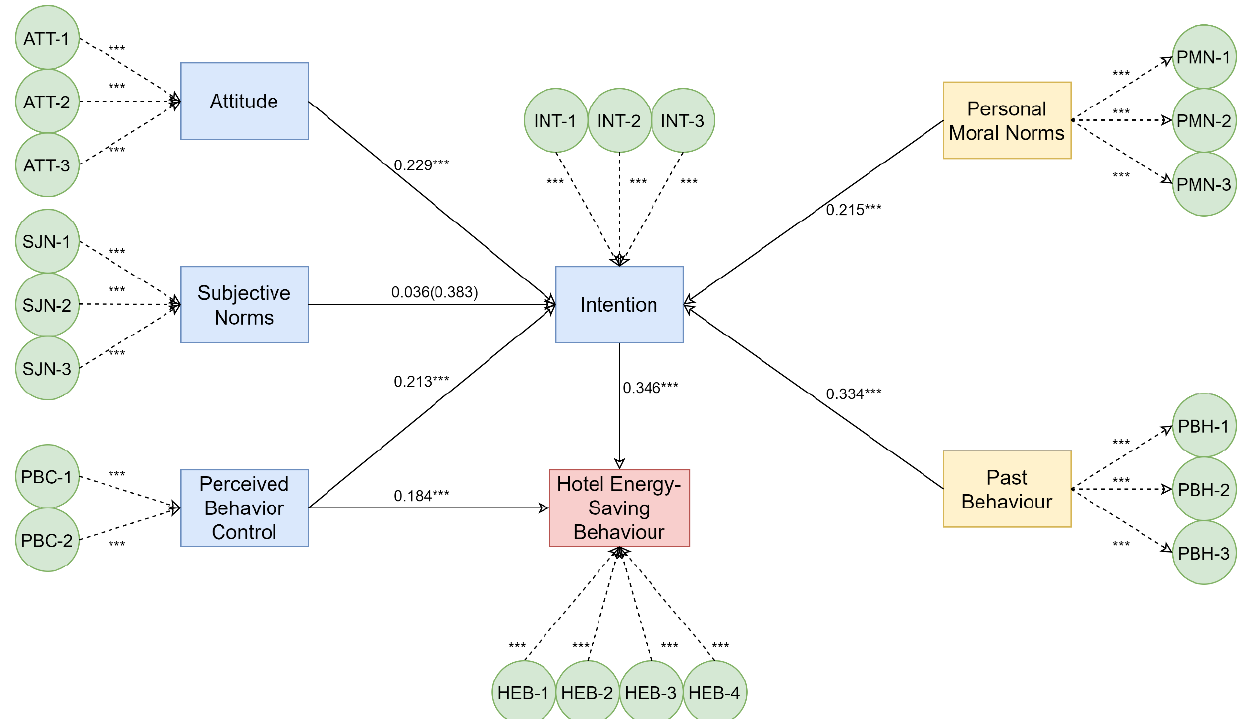
Figure 5. Structural modelling results of extended model I. Note: *** p < 0.001.